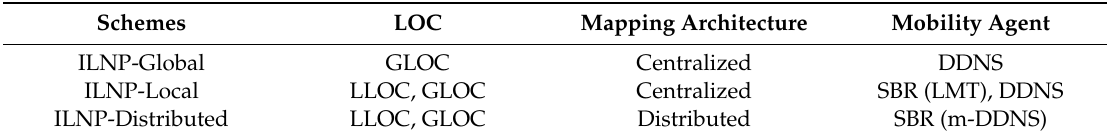
Table 2. Visiting Host Register (VHR) in LGU.com domain. Table 3. Comparison of candidate mobility control